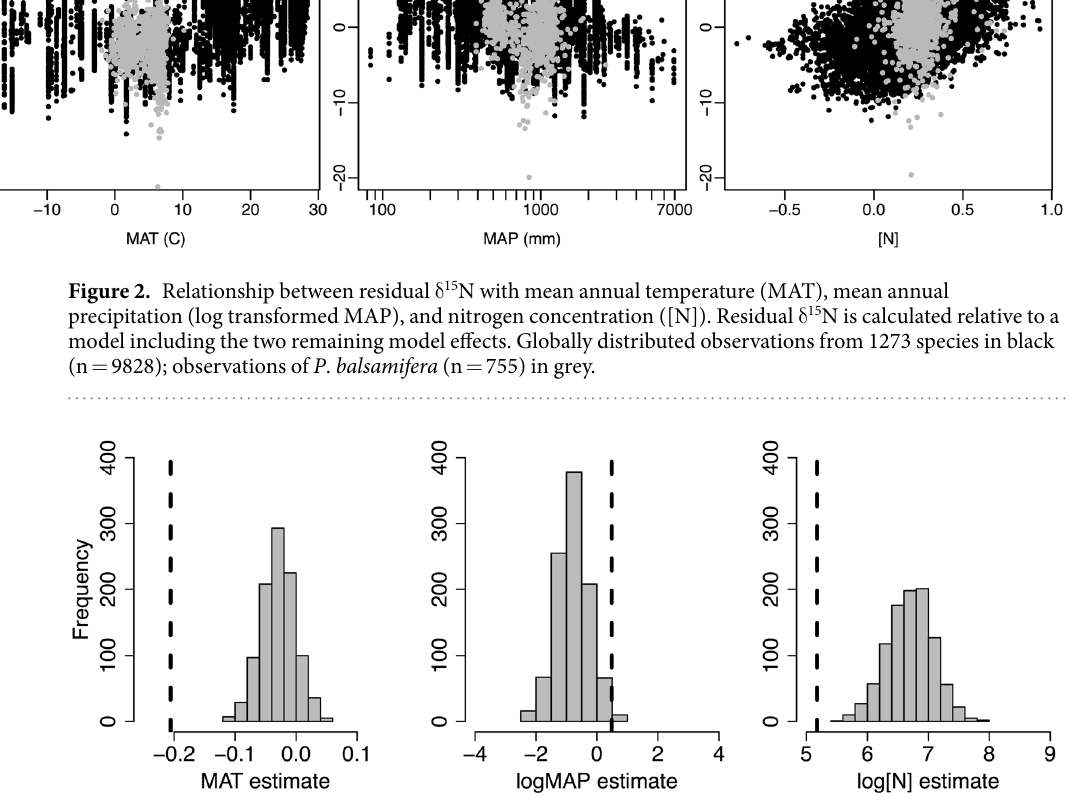
Figure 3. Distribution of model estimates on foliar δ 15 N for MAT, logMAP, and log[N] across 1000 samples of 755 observations in the global N database. Models were constructed as in Fig. 2. Samples were constrained to be within the climate range of P. balsamifera samples; the estimates of each effect using only P. balsamifera samples is represented by the vertical dotted line (also provided in Table 1).